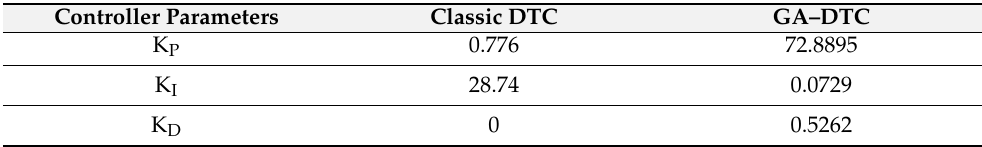
Table 3. Synthesis and optimized PID gains for DTC and the proposed GA–DTC.